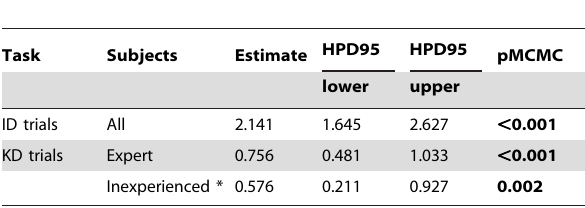
Table 2. Estimates of overall intercept (mean response score) in the individual discrimination (ID) and kin